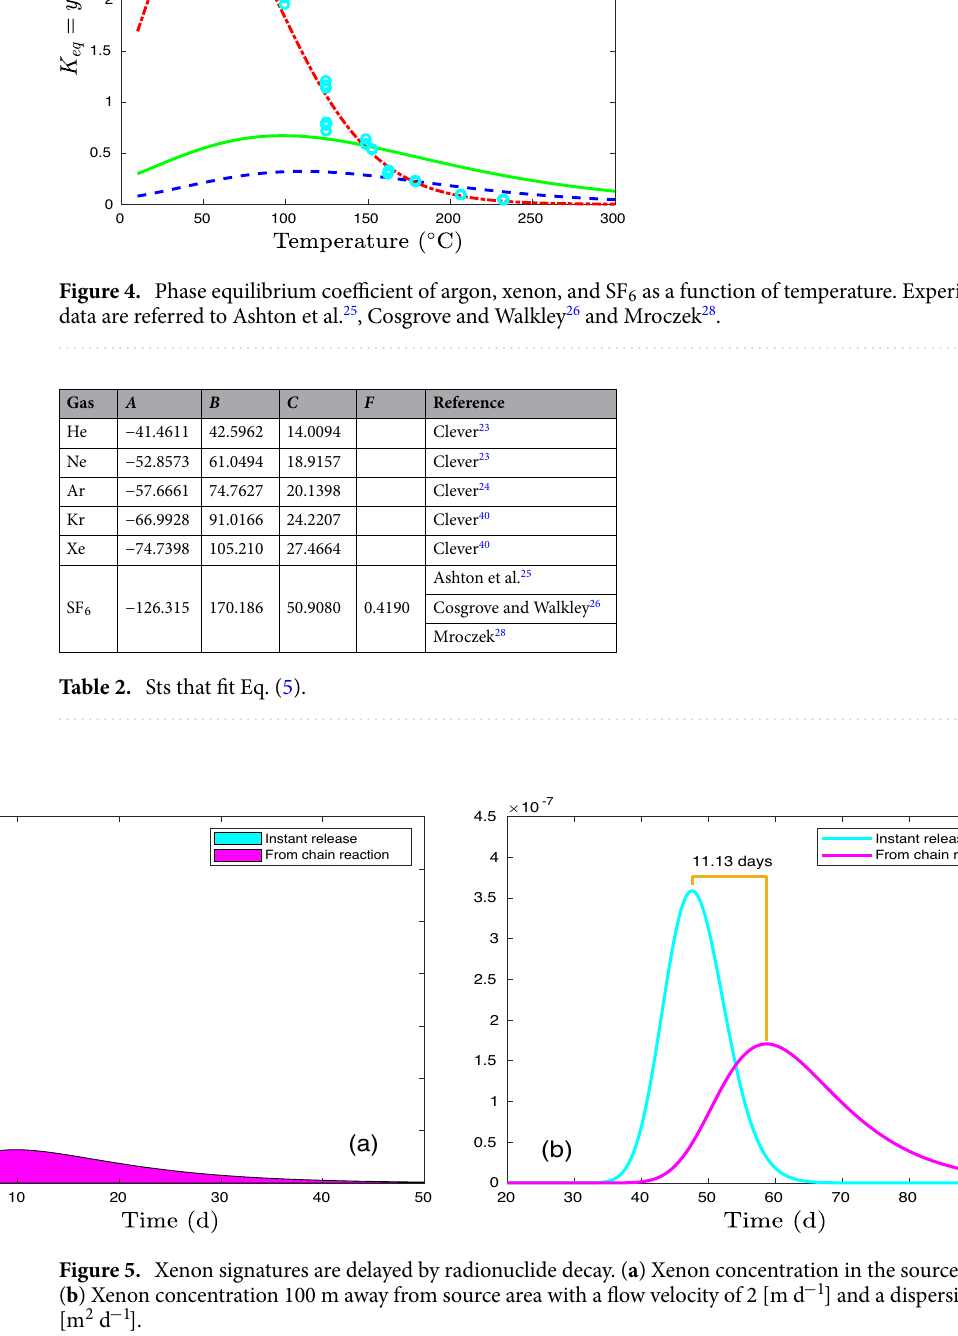
1 ] and a dispersivity of 1.0